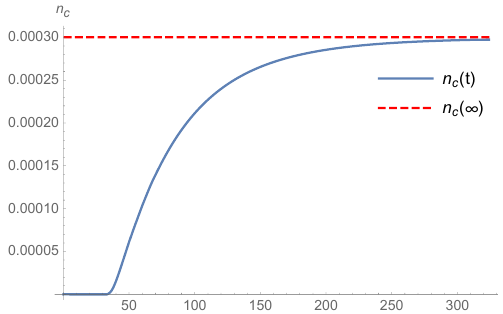
Figure 4. Corresponding evolution of the condensate for the system in Figure 3.